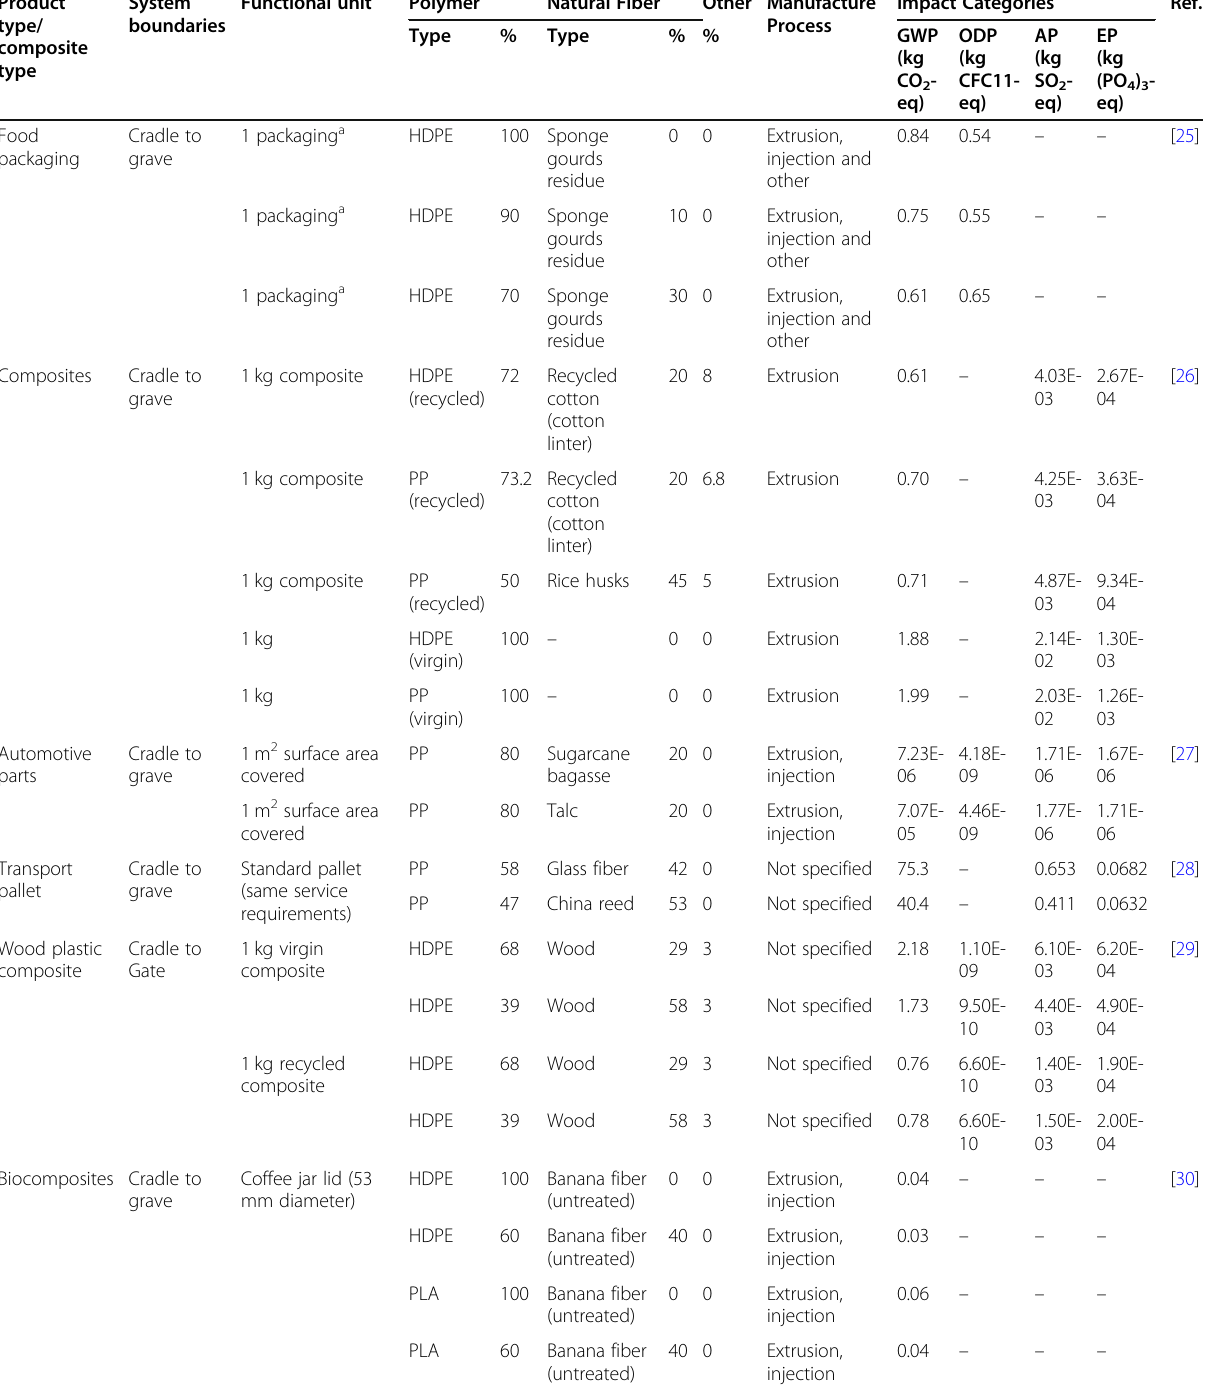
Table 7 Life Cycle Analysis comparison of different thermoplastic/natural fiber composites Product